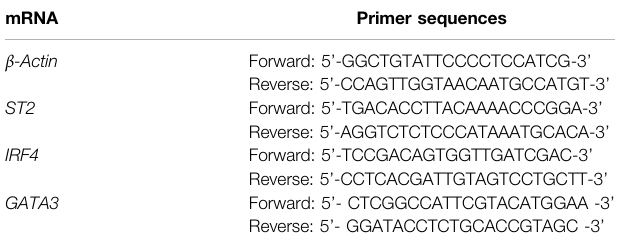
TABLE 2 | Primer sequences used in quantitative PCR